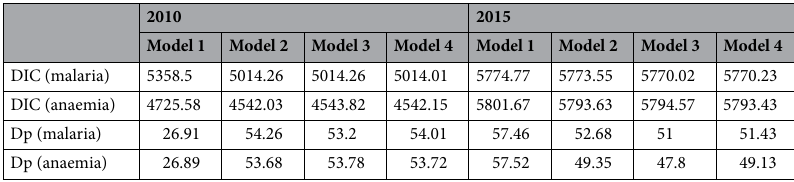
Table 3. Model comparisons for malaria and anaemia.